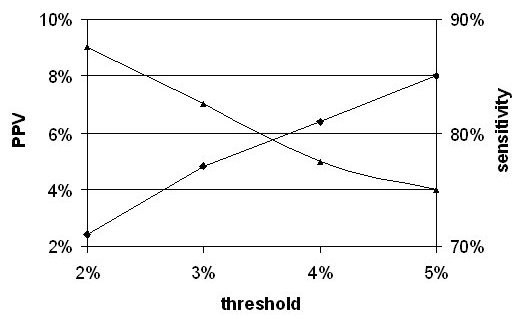
External validation of EpiJen. Sensitivity (-◆-) and PPV (-▲-) are given at different thresholds.